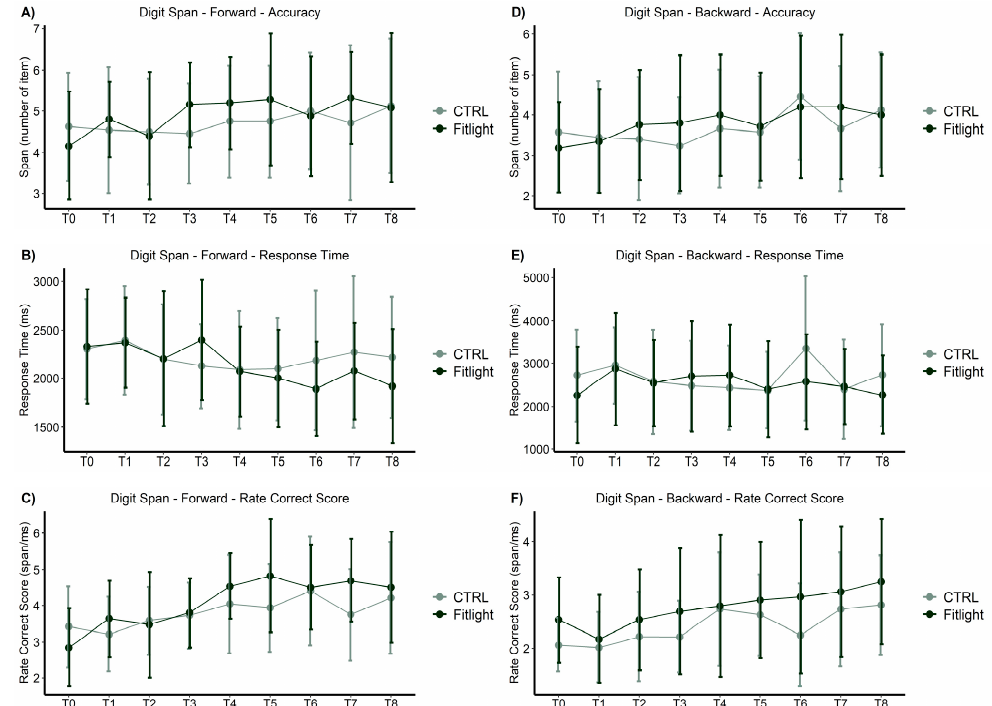
Figure 3. Digit Span measures over time and between groups in all conditions: ( a ) Span measures in Forward-Digit Span; ( b ) response time in Forward-Digit Span; ( c ) rate of correct scores in Forward-Digit Span; ( d ) span measures in Backward-Digit Span; ( e ) response time in Backward-Digit Span; ( f ) rate of correct scores in Backward-Digit Span.